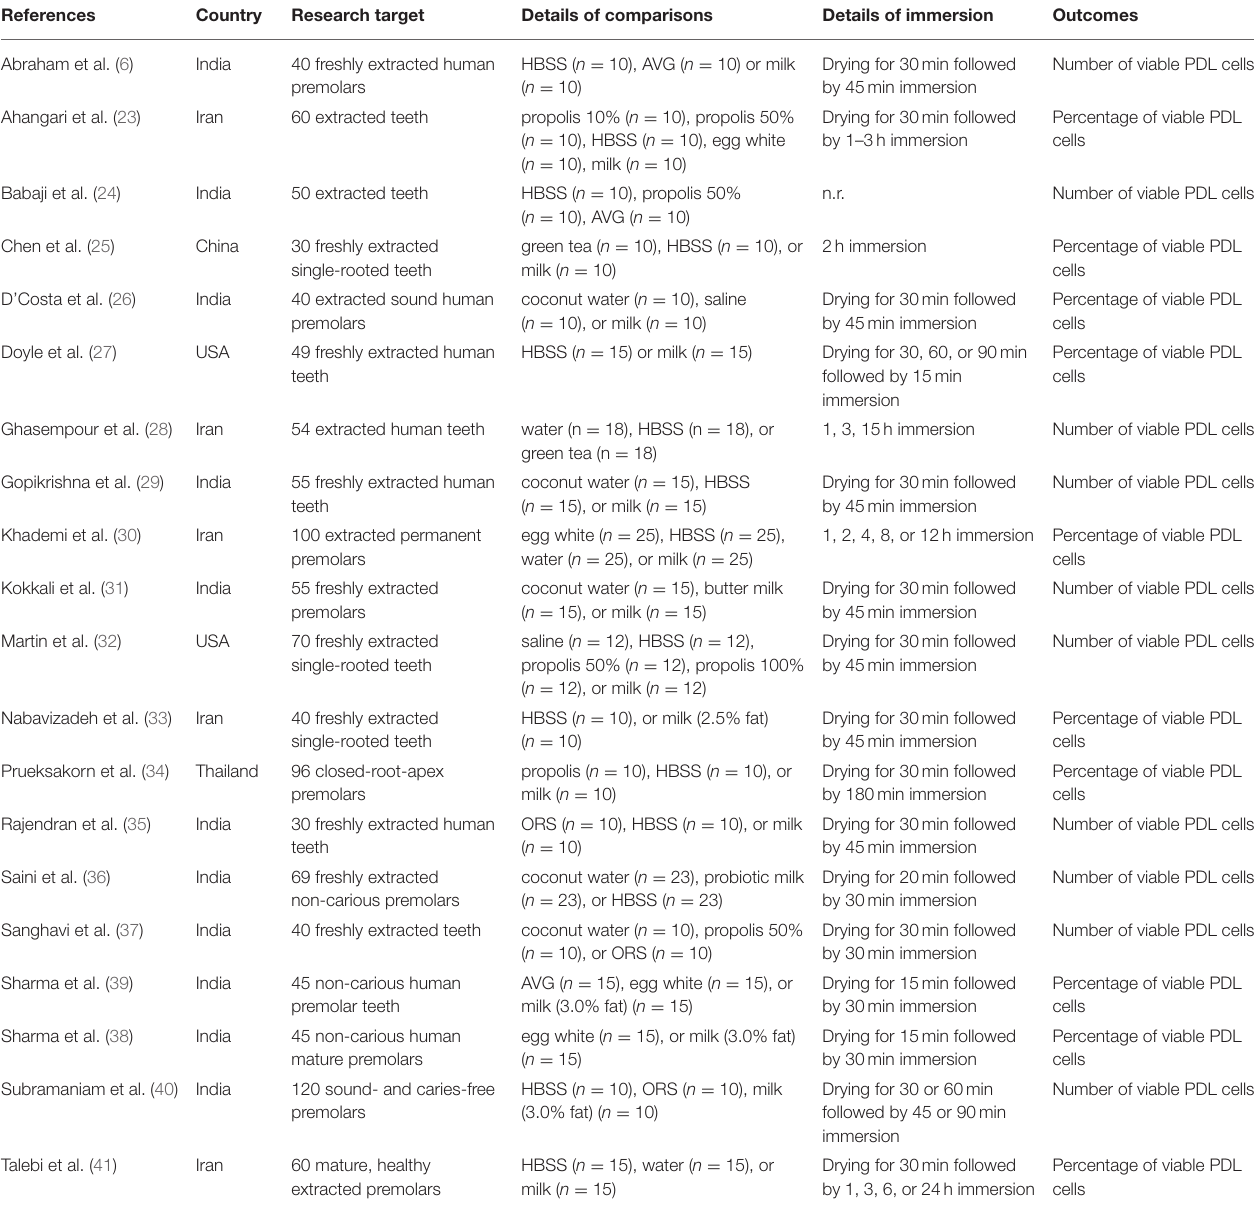
TABLE 1 | Basic characteristics of included 20